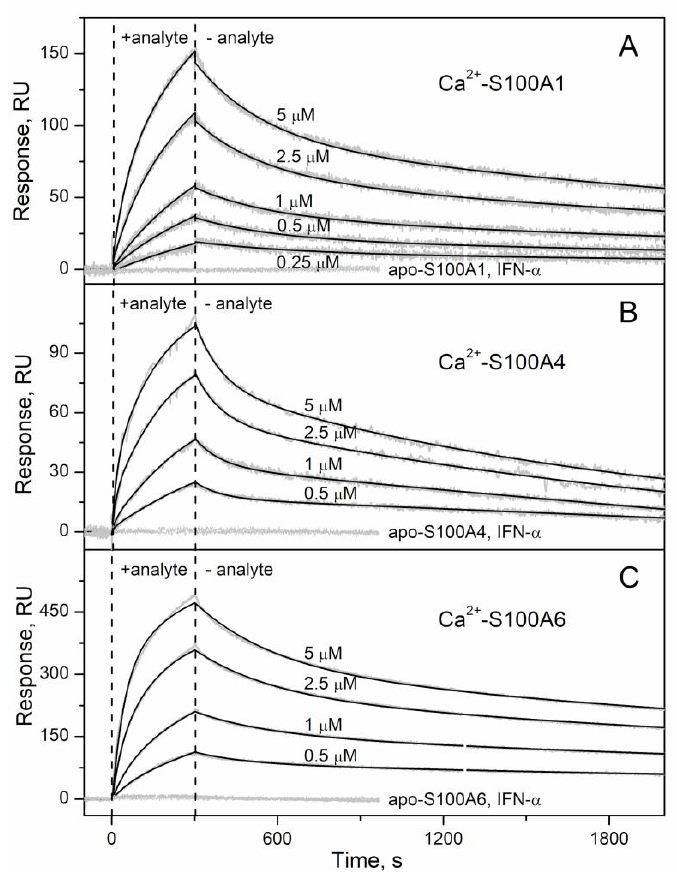
Figure 1. Kinetics of the interaction between IFN- β and Ca 2+ -bound S100 proteins at 25 °C (1 mM CaCl 2 , pH 7.4), monitored by SPR spectroscopy using IFN- β as a ligand and S100A1 (panel A ), S100A4 ( B ) or S100A6 ( C ) as an analyte (0.25 – 5 µM). The sensograms for control experiments are also indicated: Ca 2+ -depleted S100 proteins (1 µM; 1 mM EDTA) were used as an analyte; IFN- α served as a ligand. Grey curves are experimental, while black curves are theoretical, calculated according to the heterogeneous ligand model [1] (refer to Table 1 for the fitting parameters).